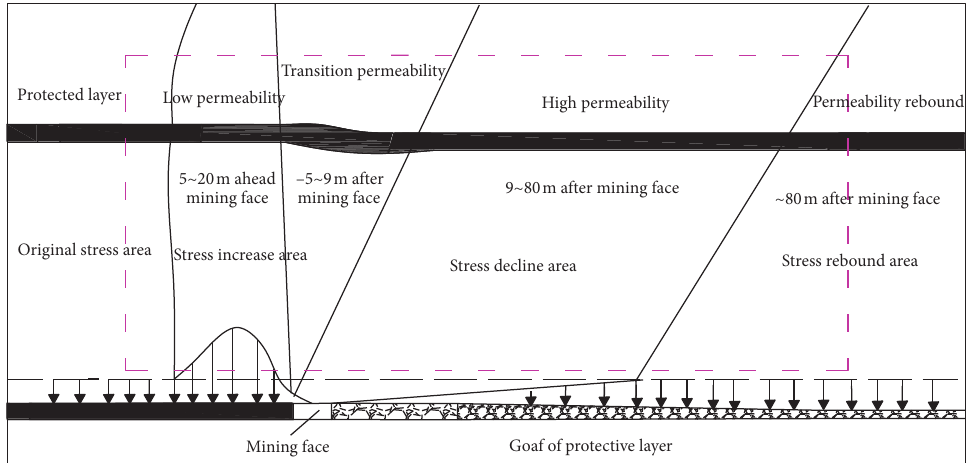
Figure 2: Permeability and application scope of gas-solid coupling equation in the lower protective layer mining.